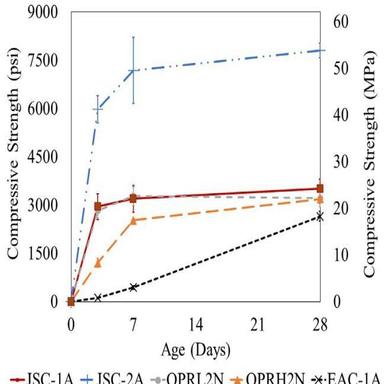
Compressive strength at 3, 7, and 28 days for the five lunar regolith simulant mixtures.